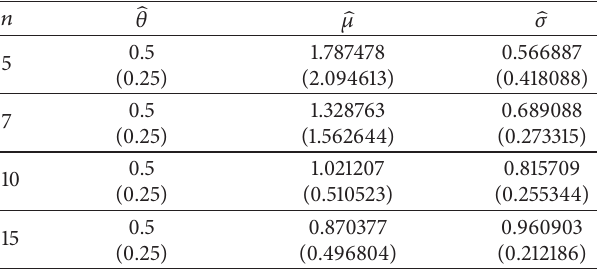
Table3:Simulationresults:MLEsof 𝜃 , 𝜇 ,and 𝜎 withtheirrespective